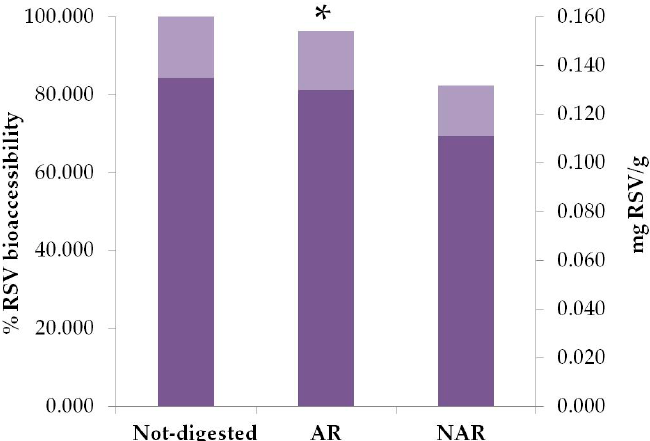
Figure 1. Intestinal bioaccessibility of RSV contained in Taurisolo ® after in vitro gastrointestinal digestion on AR and NAR capsules. Data are expressed as mean values in mg RSV per g of extract, and percentage of RSV intestinal bioaccessibility. Statistic significance is calculated by Student’s